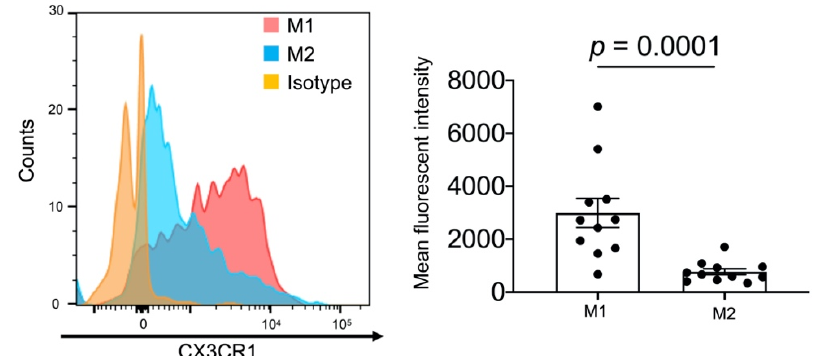
Figure 6. Expression of CX3CR1 on M1 or M2 macrophages. BALF cells obtained from SKG-ILD mice were analyzed for the expression of CX3CR1 on M1 and M2 macrophages. ( A ) Representative histogram of CX3CR1 expression on CD45 + CD68 + CD86 + CD206 − -gated cells (M1) or CD45 + CD68 + CD86 − CD206 + -gated cells (M2). ( B ) Pooled data on the mean fluorescent intensity of CX3CR1 expression on M1 or M2 macrophages ( n = 11). Data are expressed as means ± SEM. The